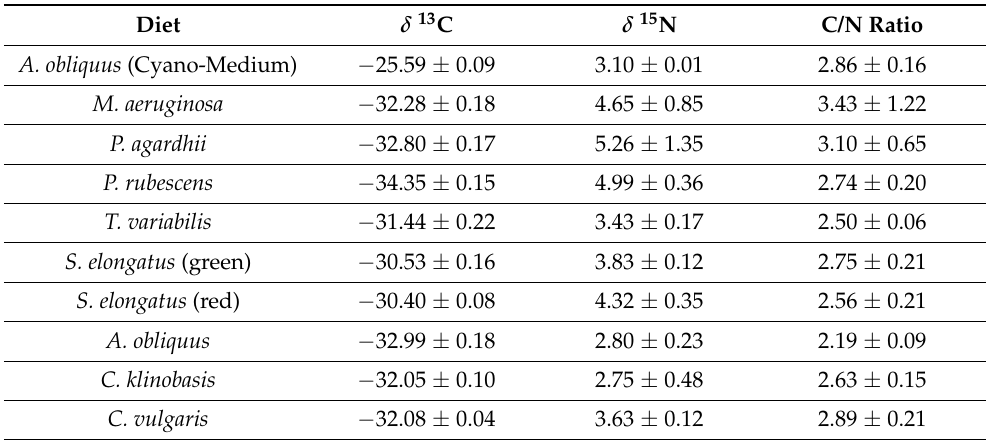
Table 2. Mean ( ± SE) stable isotope values and C/N ratio of each phytoplankton species used as a dietary source for the diet switch experimental